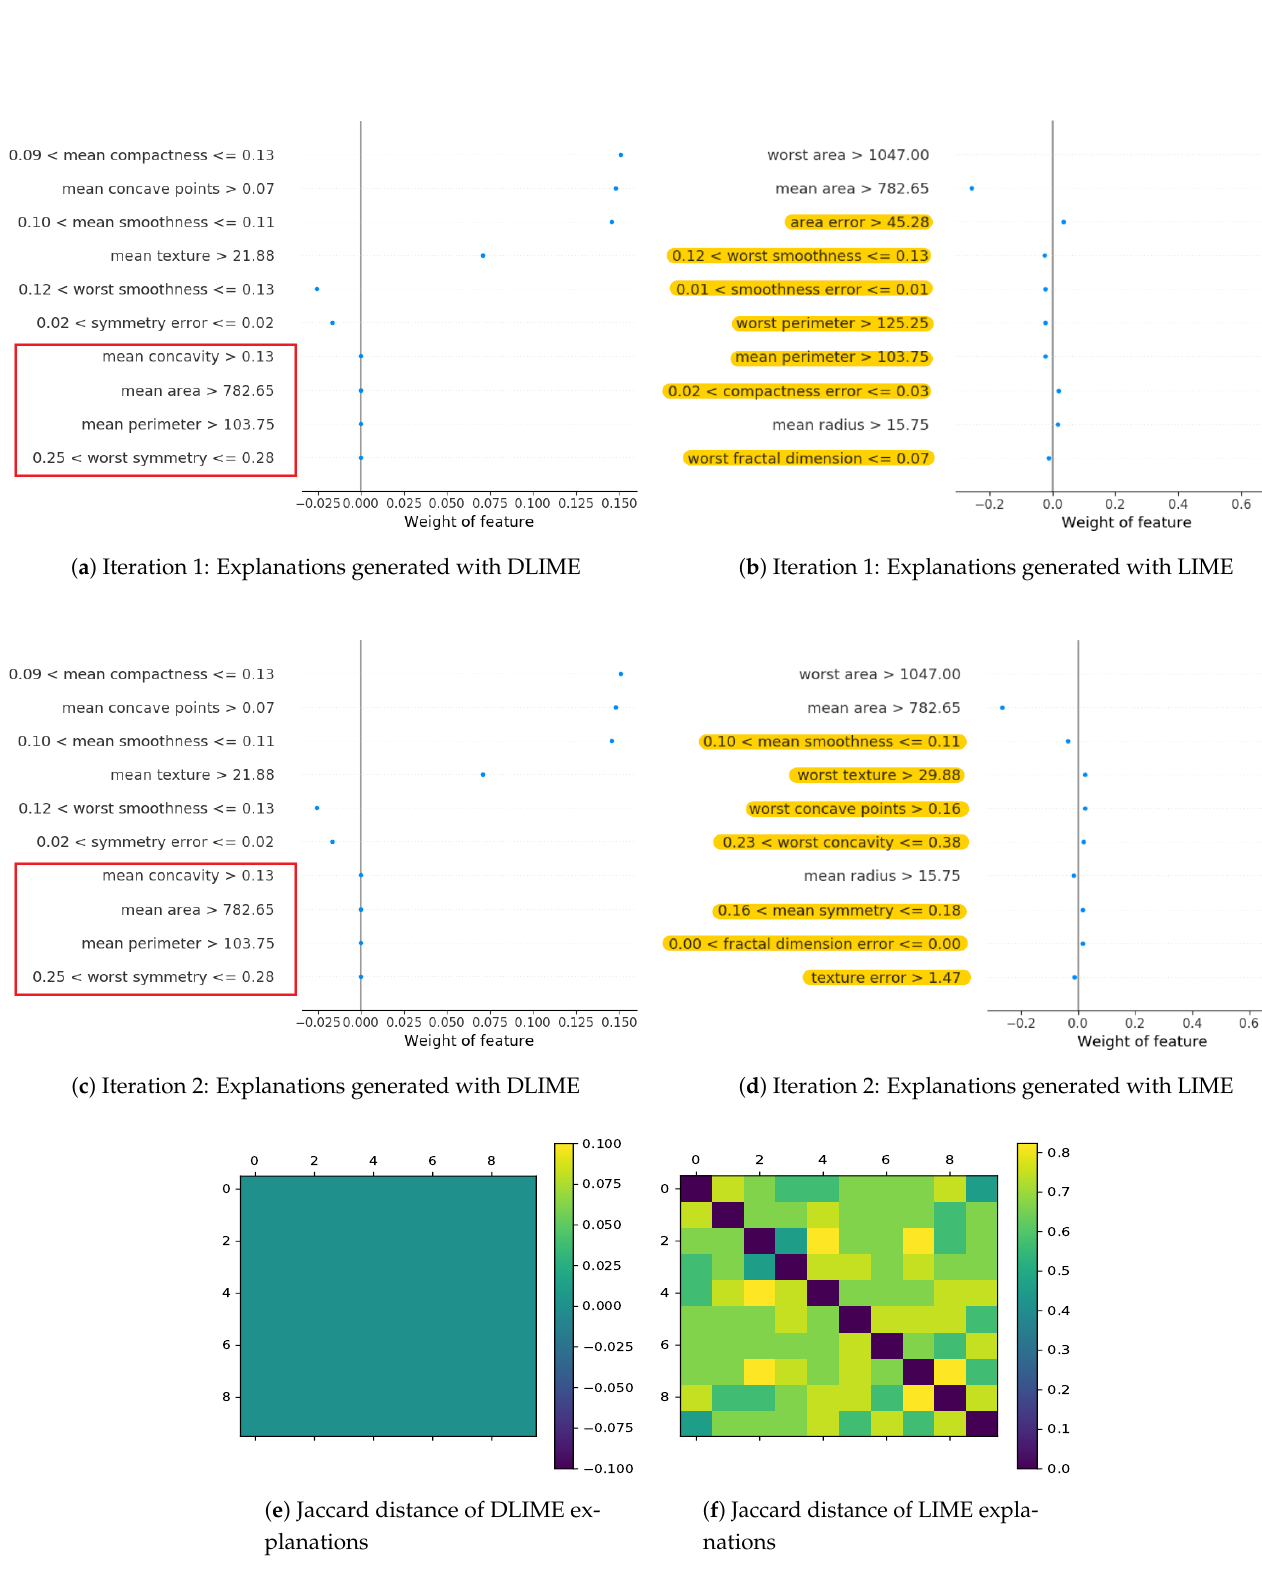
Figure 5. Explanations generated for neural network by DLIME-Tree and LIME, and respective Jaccard distances over 10 iterations. Features outlined with red color in ( a , c ) represents insignificant features with 0 contribution. Highlighted features with yellow color in ( b , d ) represents the difference in selected features for the same instance over 2 iterations. The order of features in ( a – d ) is higher to lower importance. ( e , f ) shows the Jaccard distance matrix among the features selected over 10